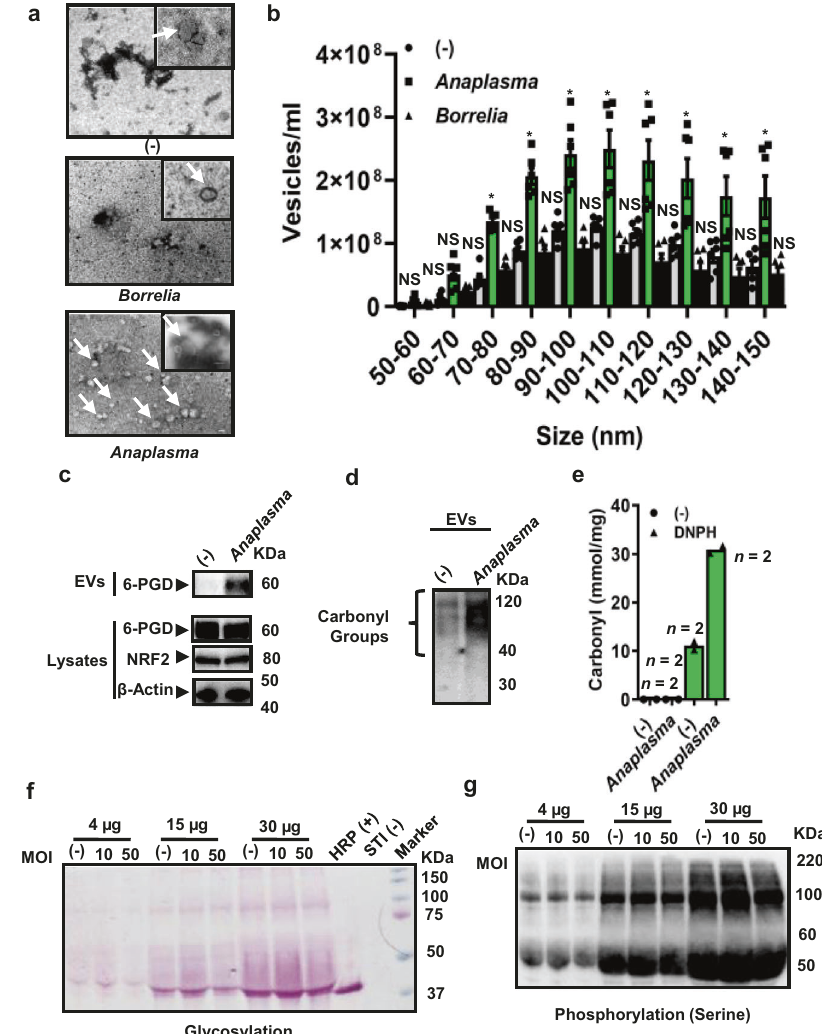
Fig. 5 Tick EVs are modi fi ed by the intracellular bacterial lifestyle. a Transmission electron microscopy of EVs puri fi ed from I. scapularis ISE6 cells infected with A. phagocytophilum or B. burgdorferi . Scale bars: 100 nm, large panel = 11,000x; small panel = 30,000x. The image is representative of two independent experiments. b I. scapularis EVs released from A. phagocytophilum or B. burgdorferi- stimulated ISE6 cells. Means ± standard error of the mean (SEM) are plotted. ( − ) unstimulated cells. (* p < 0.05). Data is representative of three technical and two biological replicates. SDS-PAGE immunoblots showing increased release of c 6-phosphogluconate dehydrogenase (PGD) (50 µ g for lysates and 40 µ l for EV immunoblots, respectively); NRF2 nuclear factor erythroid 2-related factor 2. d 15 µ g of EVs derived from tick ISE6 cells infected with A. phagocytophilum (MOI 50) showing carbonylation. e Carbonylation in EVs derived from A. phagocytophilum- infected IDE12 cells (MOI 50; 15 µ g of EVs for ELISA). DNPH = 2,4-dinitrophenylhydrazine. ( − ) represents uninfected ISE6 cells lysate. f , g glycosylation and phosphorylation of proteins in uninfected and A. phagocytophilum -infected (MOI 10 and 50) EVs puri fi ed from tick ISE6 cells at indicated amounts. HRP ( + ) represents the horseradish peroxidase positive control while STI ( − ) indicates the soybean trypsin inhibitor negative control. MOI multiplicity of infection. f , g blots and gels were repeated at least twice obtaining the same results. Statistics in b was done by using Two-way ANOVA using size and treatment as variables followed by the post-hoc Sidak test for comparisons. (* p < 0.05). Source data are provided as a Source Data fi